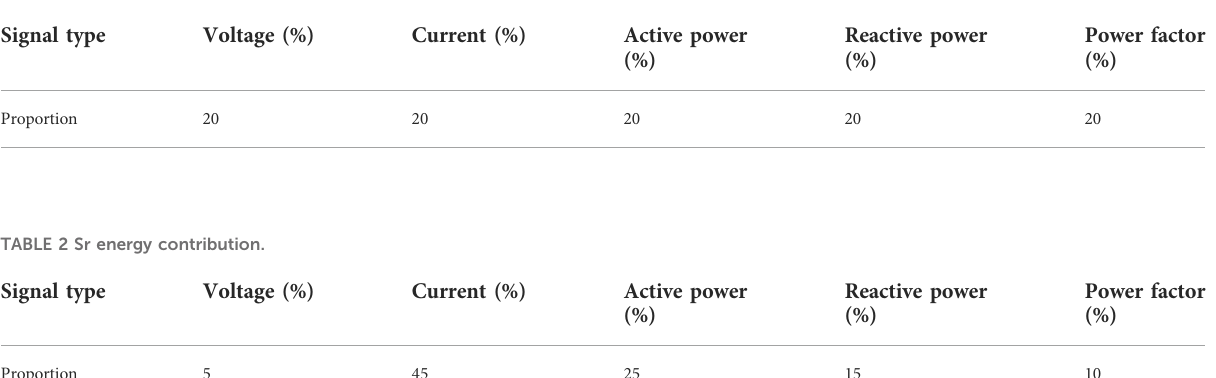
TABLE 1 Energy contribution.